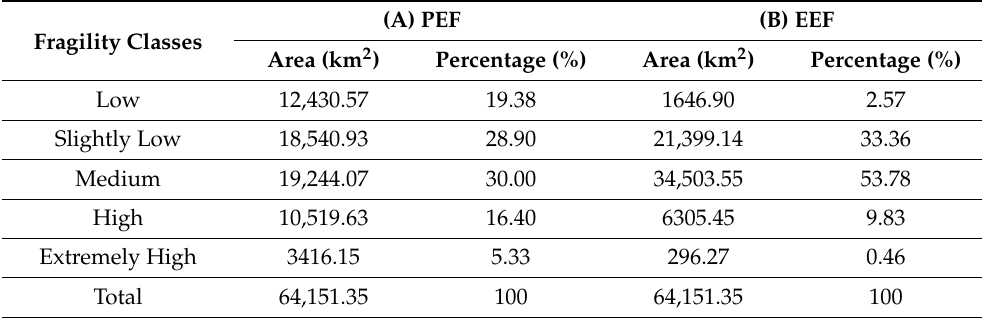
Figure 5. ( A ) PEF (potential environmental fragility) and ( B ) EEF (emerging environmental fragility) maps of the Jequitinhonha River Hydrographic Basin, Brazil. Table 7. Area and percentage of (A) PEF classes and (B) EEF classes.